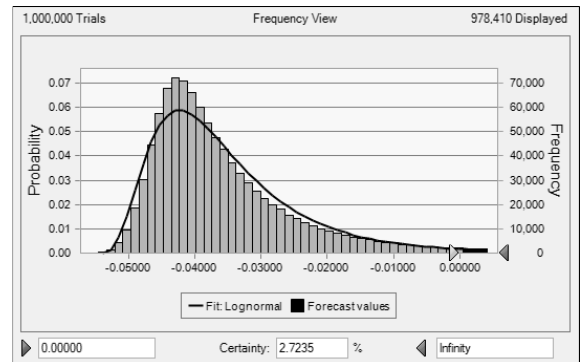
Figure 4. Simulated distribution of R for the Metronet Case. Source: Own calculation applying Crystal